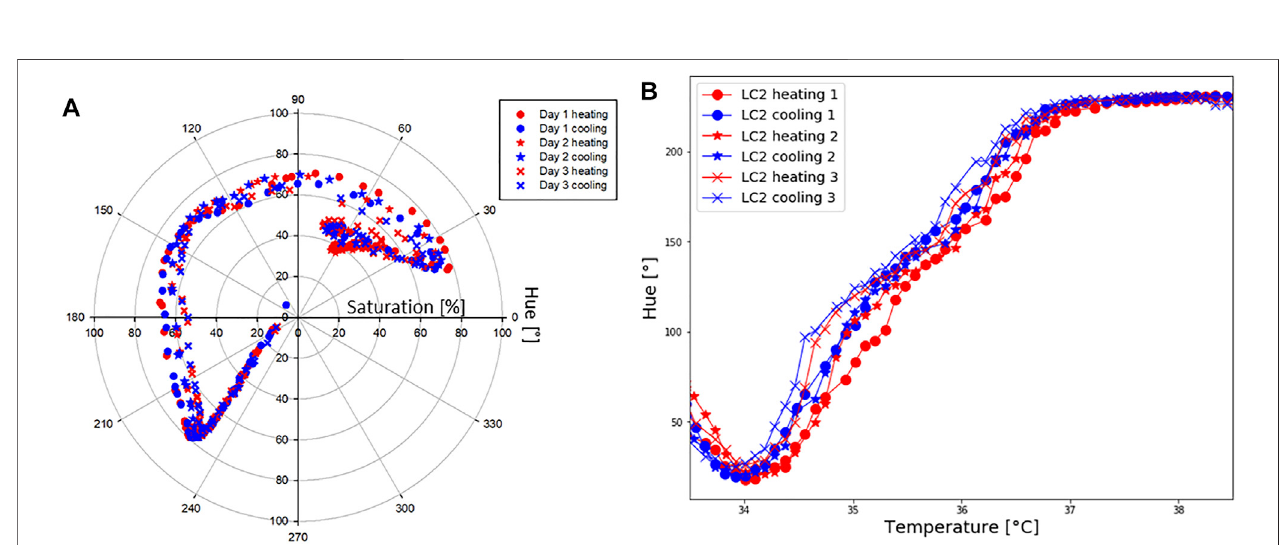
FIGURE 6 | LC2 patch: repeatability. (A) Hue [ ° ] and saturation [%] values during six separate tests, done in 3 days. (B) Hue [ ° ]-temperature [ ° C] test performed to study